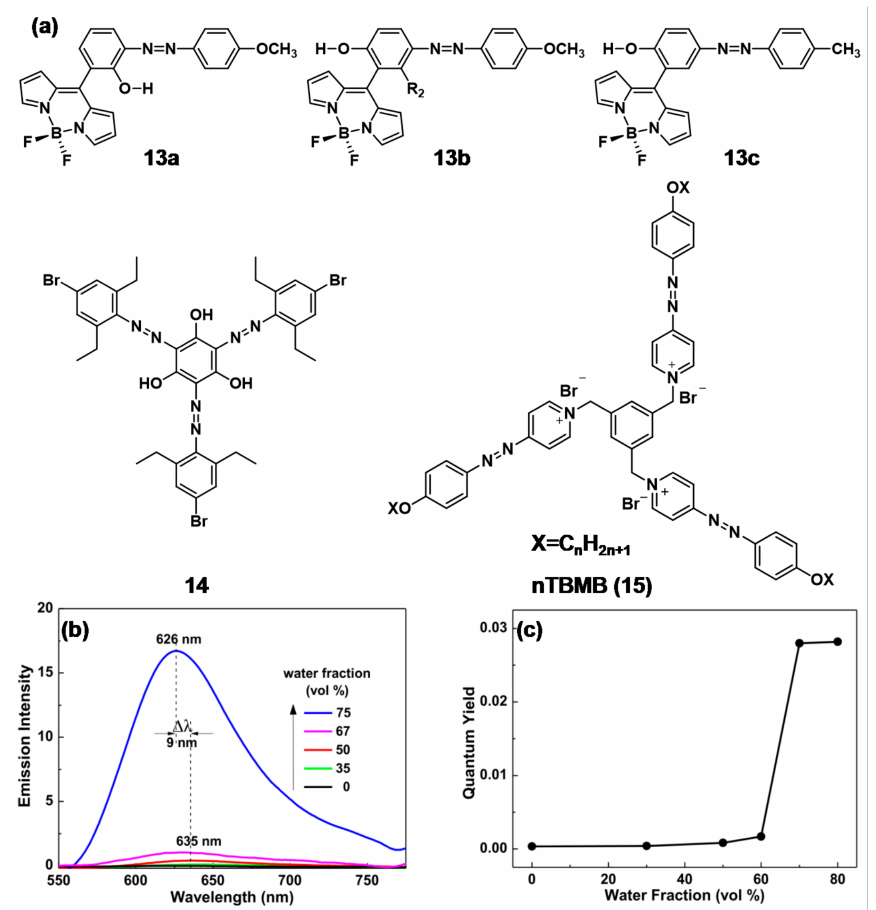
Figure 11. ( a ) The molecular structure of AIE azobenzene molecules 13 , 14 , 15 . ( b ) Emission spectra of the 10TBMB ( 15 ) in H 2 O/THF mixtures with different water volume fractions ( f w , vol% volume fraction). (c) Changes in the fluorescence quantum yield ( Φ F ) of 10TBMB ( 15 ) in H 2 O/THF mixtures with f w . ( b , c ) were reproduced with permission from [85]. Copyright 2018 Wiley-VCH Verlag GmbH & Co. KGaA, Weinheim.